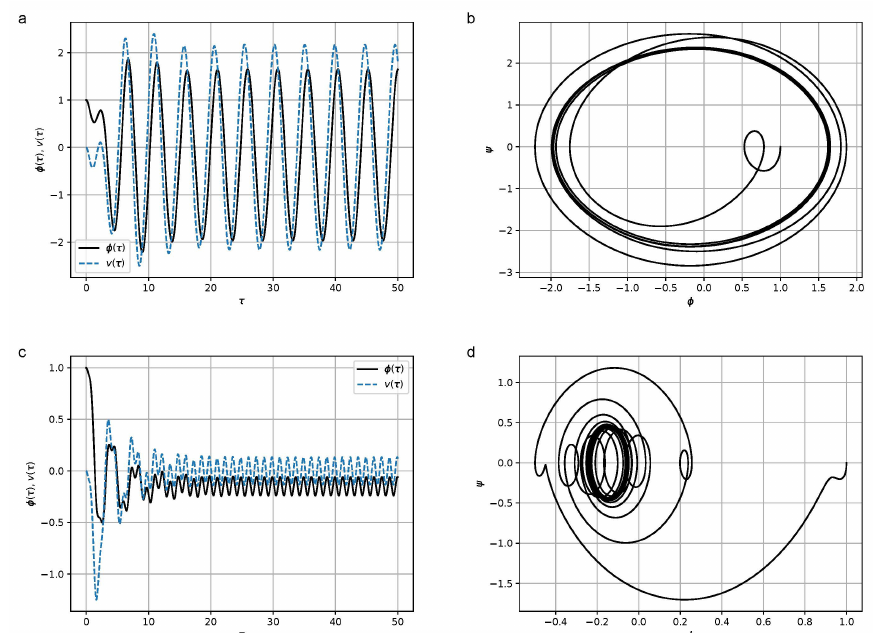
Figure 9. ( a ) Dependence of the declination angle of the pendulum, ϕ ( τ ) , and the stress, v ( τ ) , from the dimensionless time at Ω = 1.3 and H = 0.5; ( b ) Phase portrait of the oscillations of the pendulum ψ ( ϕ ) at Ω = 1.3, H = 0.5; ( c ) Dependence of the declination angle of the pendulum, ϕ ( τ ) , and the stress, v ( τ ) , from the dimensionless time at Ω = 5.0 and H = 0.5; ( d ) Phase portrait of the oscillations of the pendulum ψ ( ϕ ) at Ω = 5.0, and H = 0.5. Parameter values were σ = 1.5, ω = 1.2, and K = 2.0.